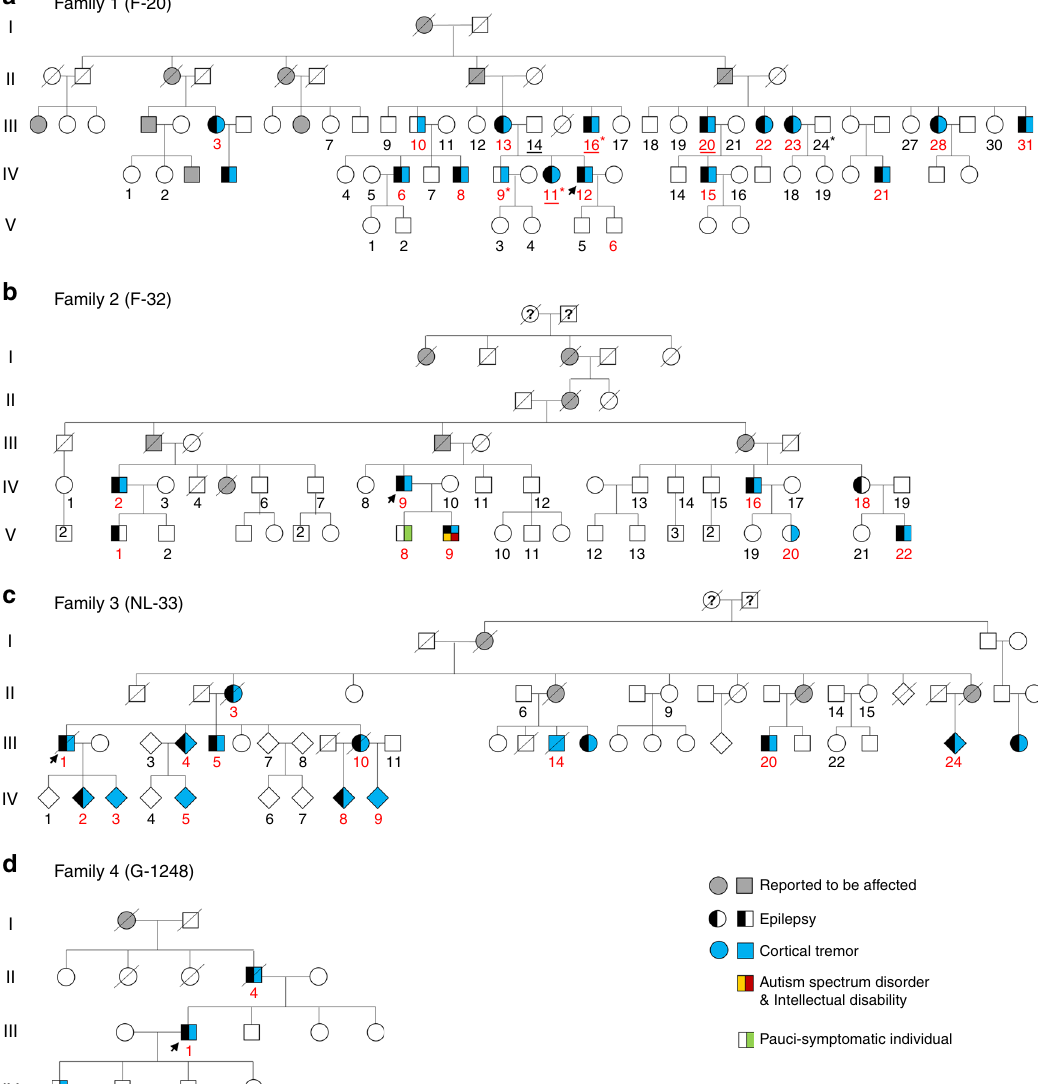
Fig. 1 Pedigrees of families with MARCH6 expansions. Pedigrees of Families 1 ( a , French), 2 ( b , French), 3 ( c , Dutch), and 4 ( d , German). Individuals with ID numbers in red are carriers of the expansions. Individuals with ID numbers underlined have been included in whole-genome sequencing analyses. Individuals with stars have been included in RNA-seq analyses. Black half- fi lled symbols represent individuals with seizures; Blue symbols indicate individuals with cortical or myoclonic tremor. Individuals with both cortical tremor and epilepsy appear with one half each. A re-examined carrier individual presenting with minor signs of tremor (pauci-symptomatic individual) is indicated with a green half square. One male individual of Family 2 had autism spectrum disorder (yellow corner) and intellectual disability (red corner). Arrows indicate probands. ID numbering in Families 1 and 3 is identical to that previously described